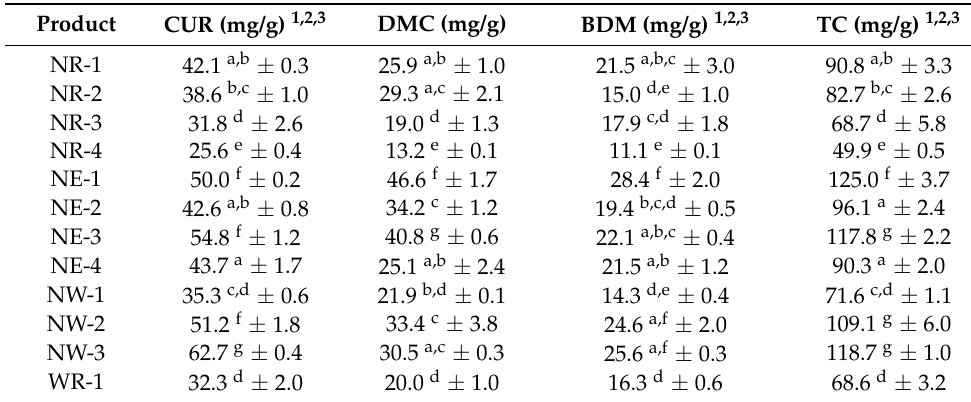
Table 3. Total curcuminoid (TC) content in C. longa